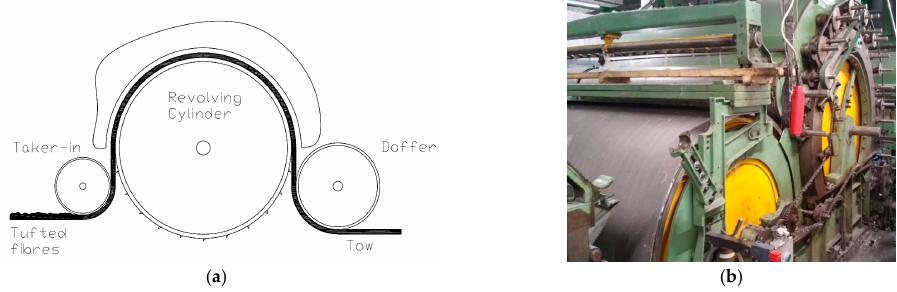
Figure 2. Carding process: ( a ) Scheme of working station (module) consisting on taker-in, revolving and doffer cylinder; and ( b ) actual working